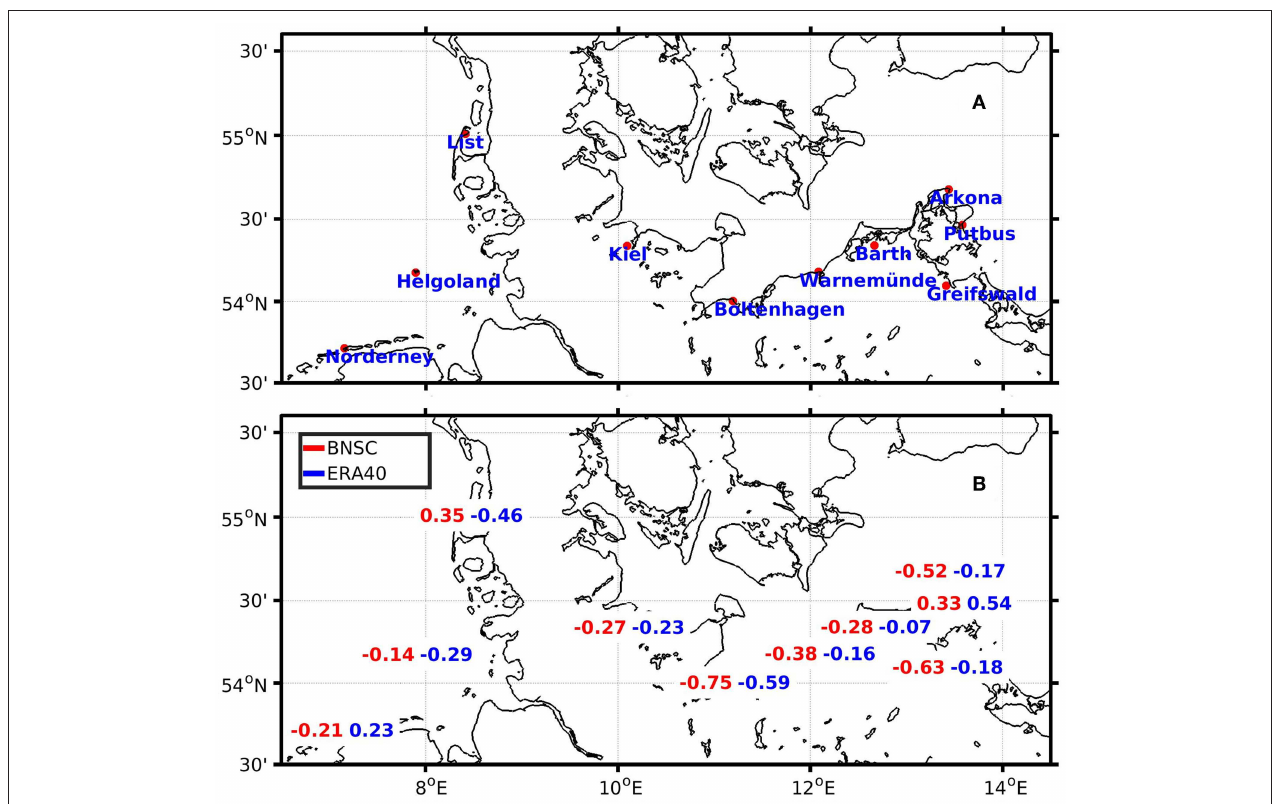
FIGURE 6 | (A) Station names, (B) Mean Difference of monthly mean sea level pressure [hPa] in measurements to closest grid cell in BNSCatm (red) and ERA-40 (blue).